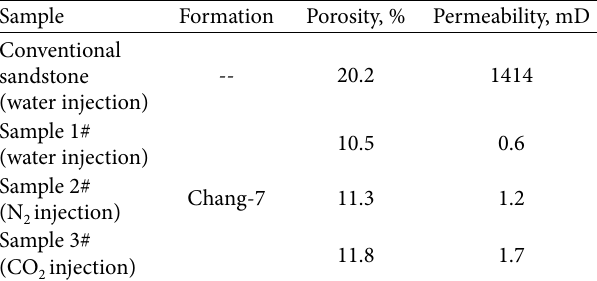
in Figure 4. The NMR apparatus (MiniMR-VTP) is made by Suzhou Niumag Analytical Instrument Corporation. The NMR T spectra agree well with the mercury intrusion results. 2